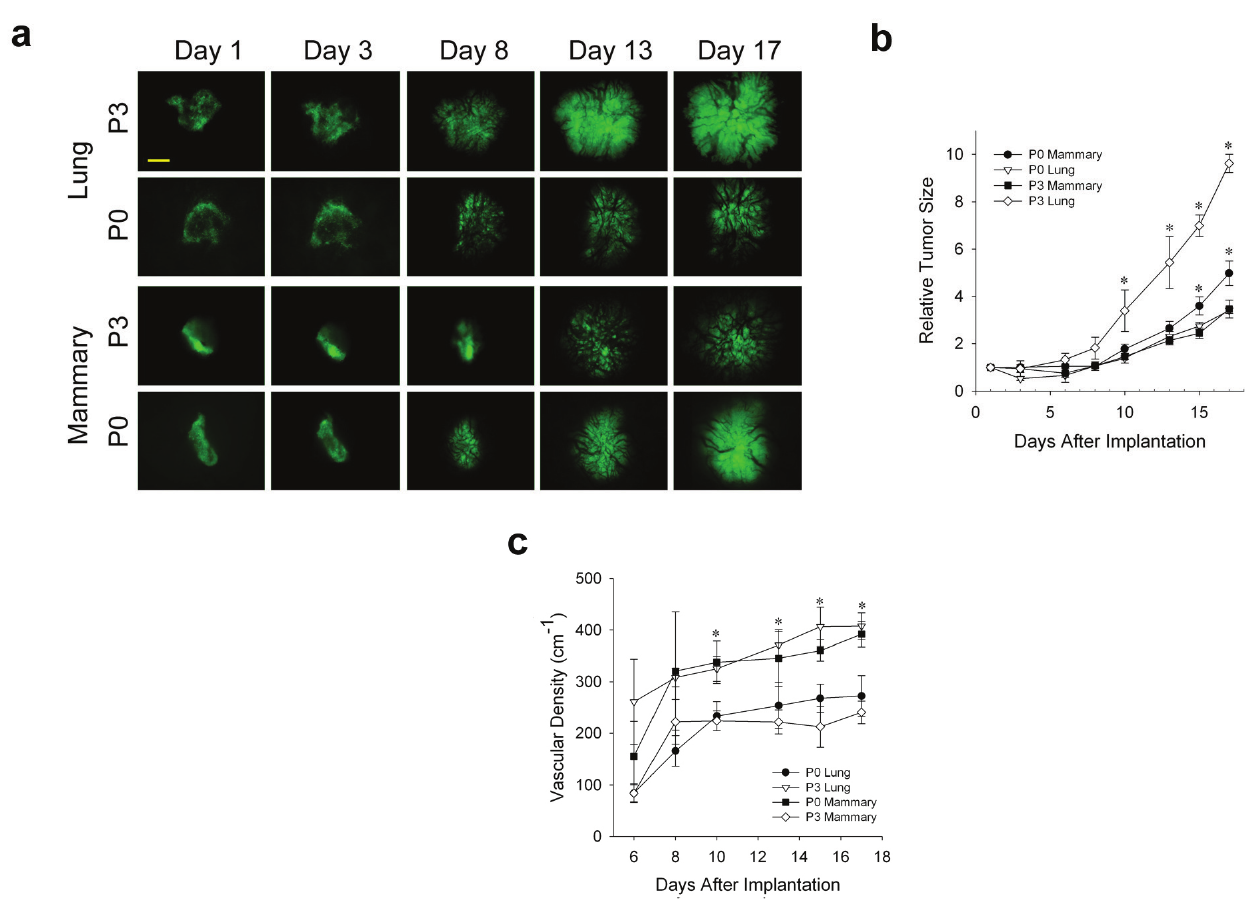
Figure 6. Tumor cell adaptation to non-orthotopic tumor microenvironment. ( a ) N202 tumor spheroids were passaged 0 or 3 times on lung tissue, as described in methods, and implanted onto engrafted lung or fat pad tissue and monitored by IVM at the indicated times. ( b ) Relative tumor growth curves. Tumor size was determined by measuring tumor area from fluorescence images on the indicated days and normalizing this relative to day 1 (see Methods). ( c ) Tumor vascular density of the indicated passaged N202 tumor spheroid was also determined as described in the methods. Scale bar = 500 μm. Mean +/- SD are shown. * = p<0.05. n = 3–4 mice for all